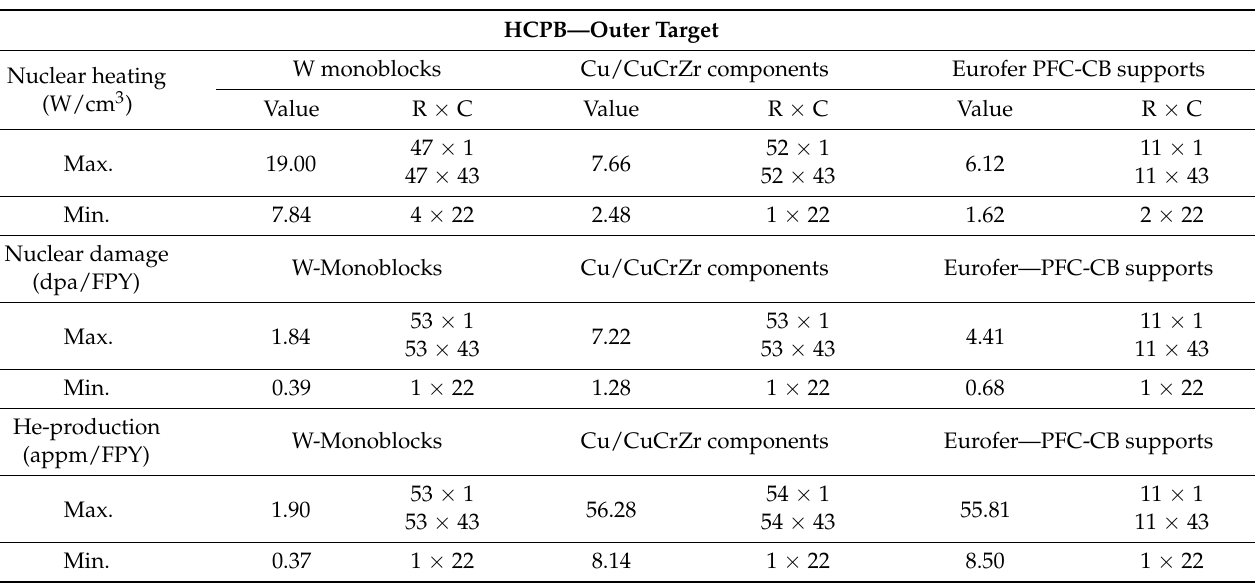
Table 9. Maximum and minimum values and related position (in terms of row (R) and column (C) of the array) of nuclear heating density (W/cm 3 ), nuclear damage (dpa/FPY), He-production (appm/FPY) on the PFCs of the HCPB outer